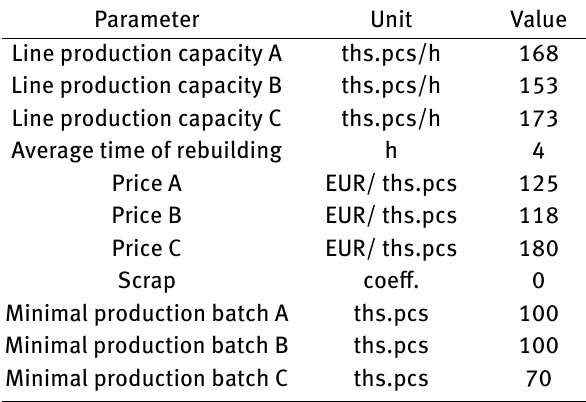
Table 2: Entry variables related to the production of products A, B,